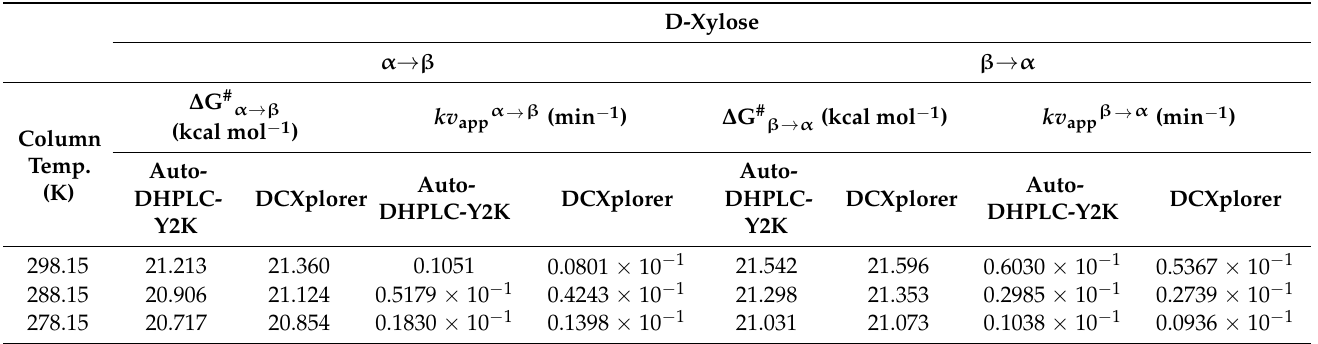
Table 3. Values of ∆ G # and kv app for the processes that lead from the α to the β anomer of D-Xylose, and vice-versa, obtained by simulating experimental dynamic chromatograms with the Auto-DHPLC-Y2K and DCXplorer